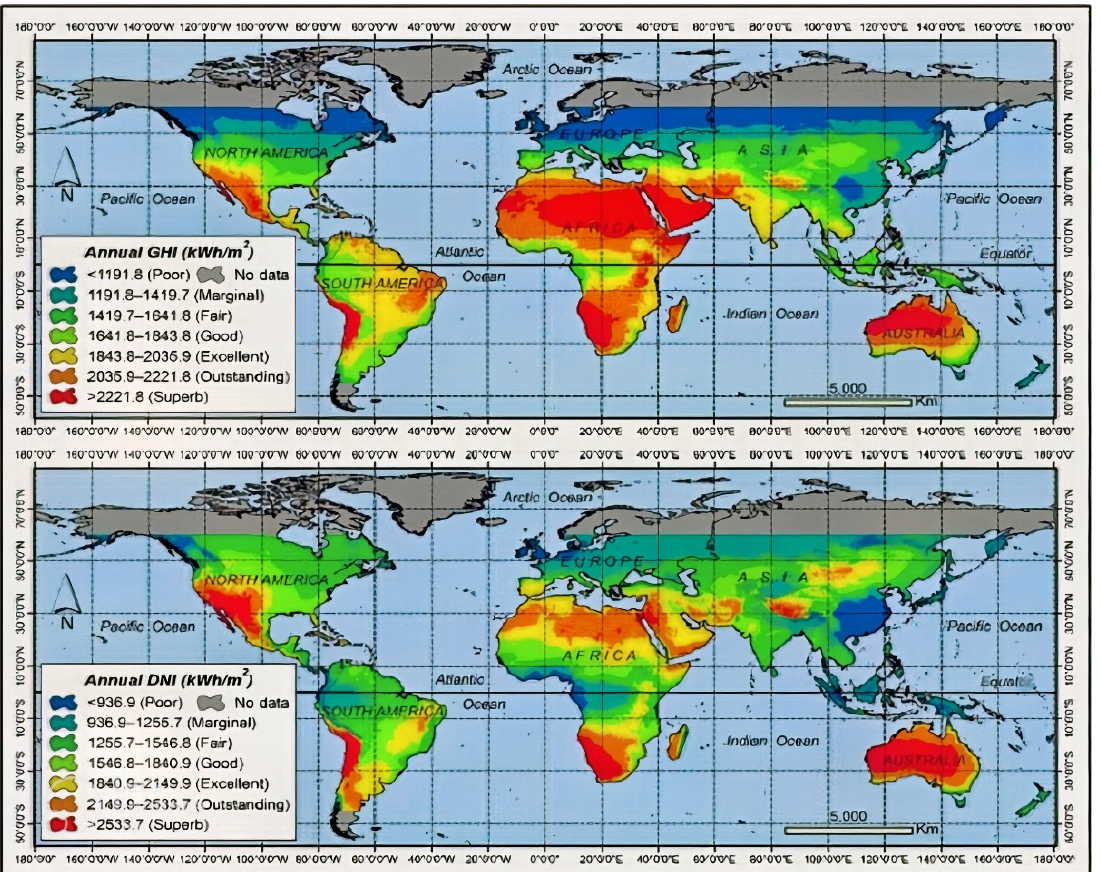
Figure 9. Global spatial representation of global horizontal irradiation (GHI) and direct normal irradiation (DNI) [78].